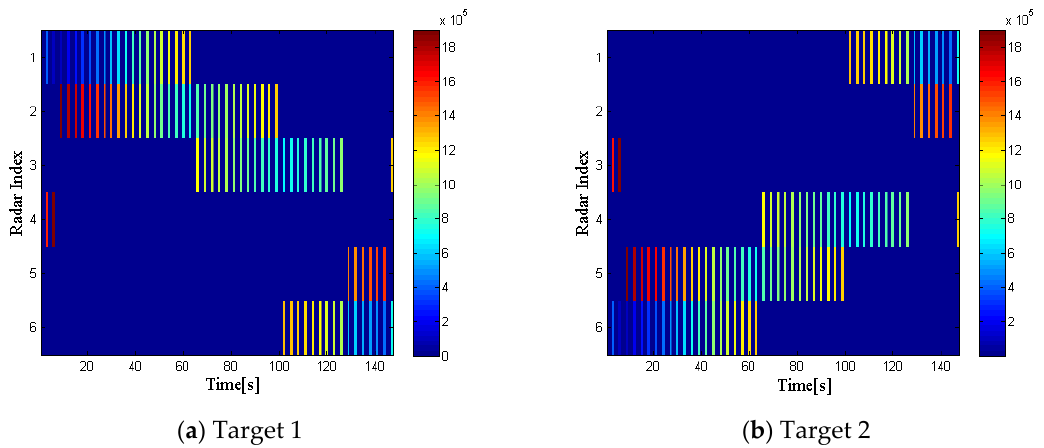
Figure 8. Radar selection and bandwidth allocation in RCS case 2.